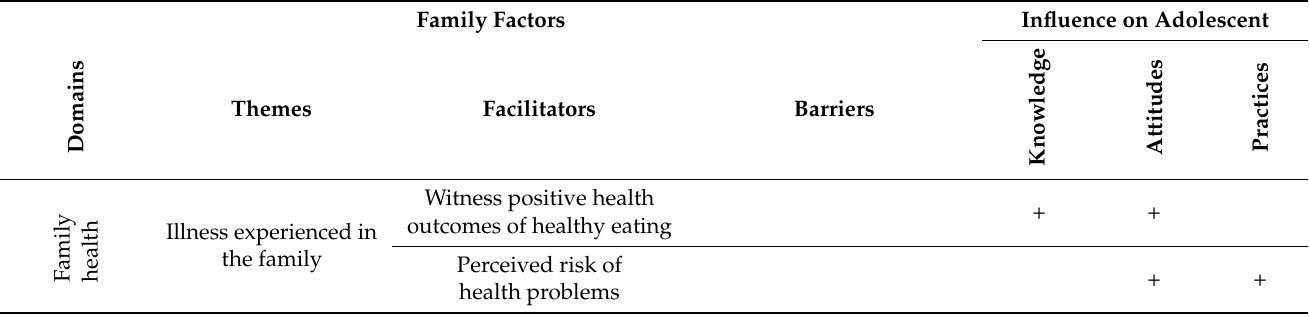
Table 3. Influence of parent characteristics on adolescent KAP of healthy